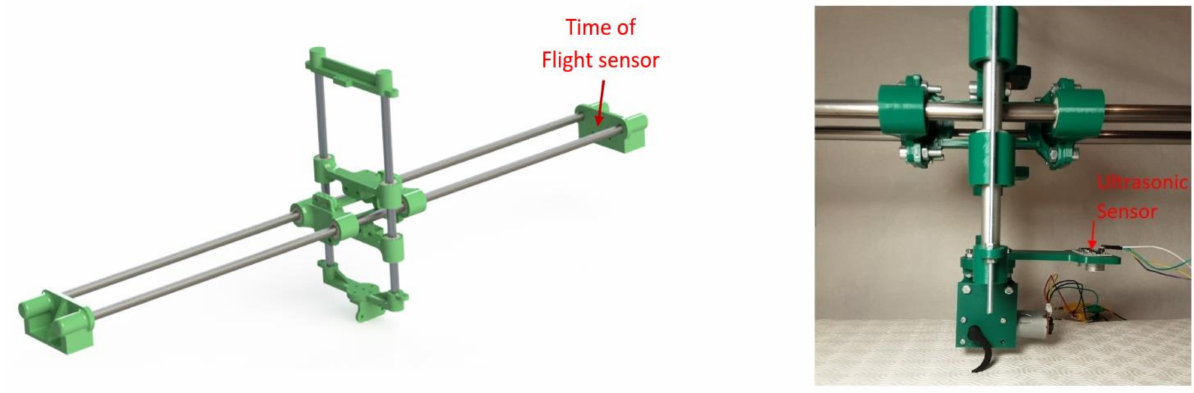
Figure 12. Test bench Computer Aided Design (CAD) render ( left ), and photograph of the test-bench’s sliding mechanism and vertical distance sensor ( right